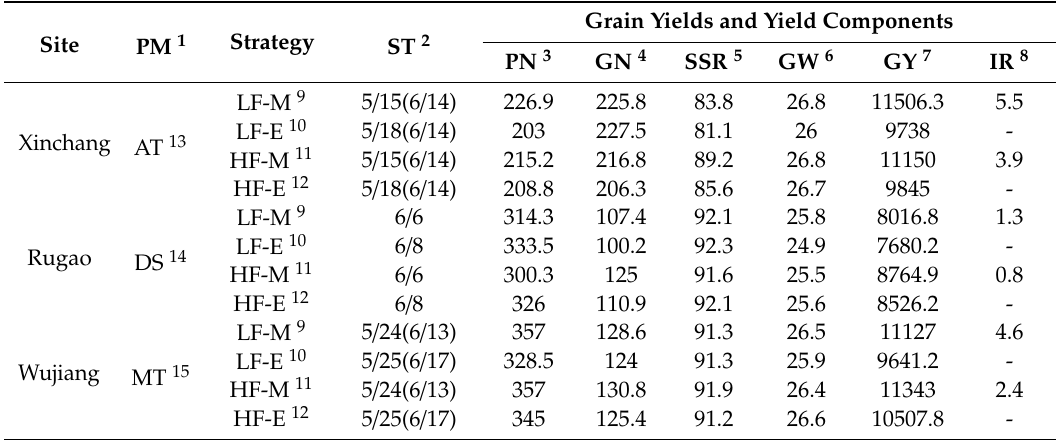
Table 3. The results of field experiment at di ff erent agro-ecological zones during 2008–2010. Site